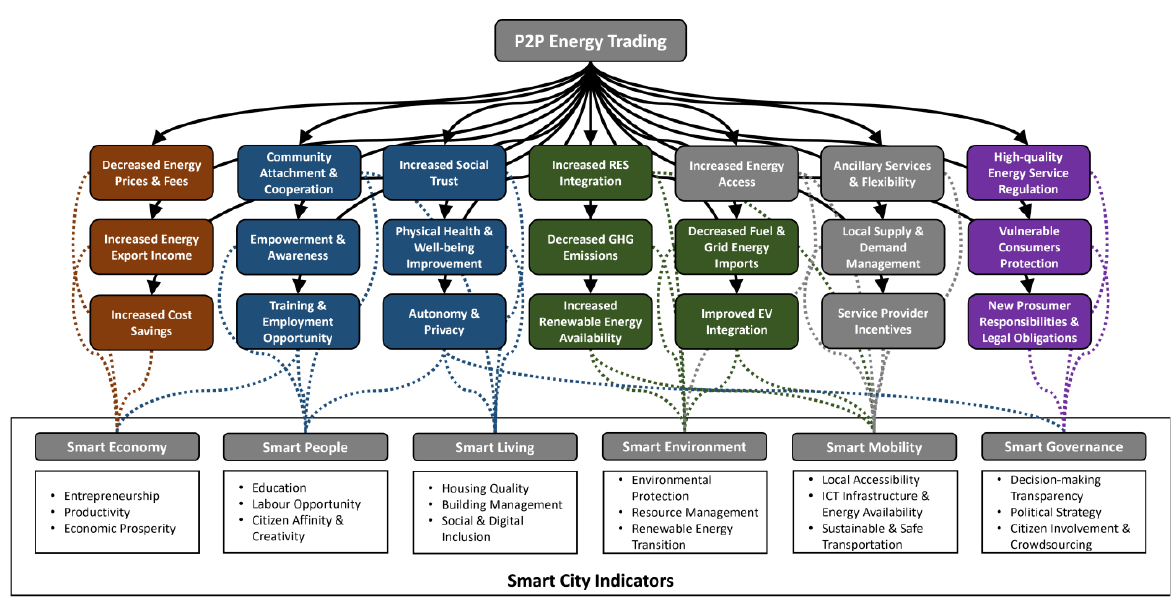
Figure 7. Representation of economic, social, environmental, technical, and legal benefits of P2P energy trading and their relationship with smart city indicators.